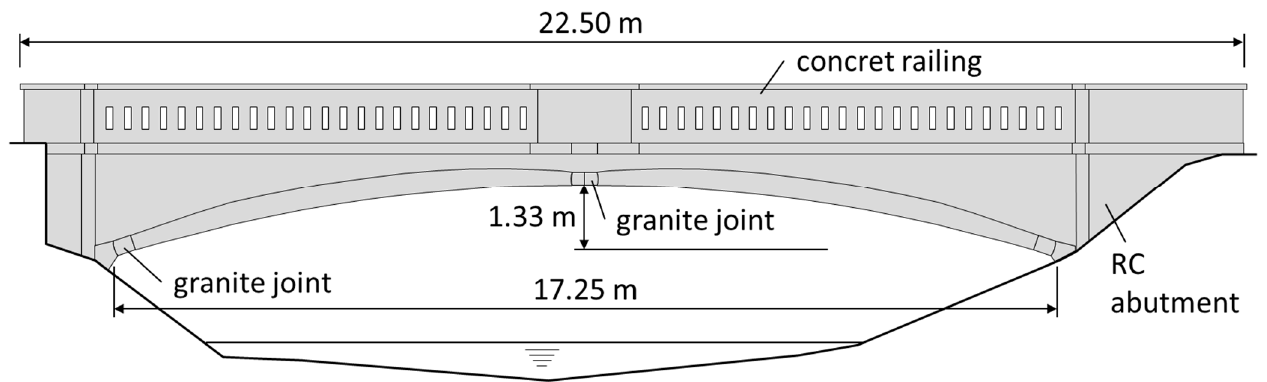
Figure 3. Side view of the bridge.